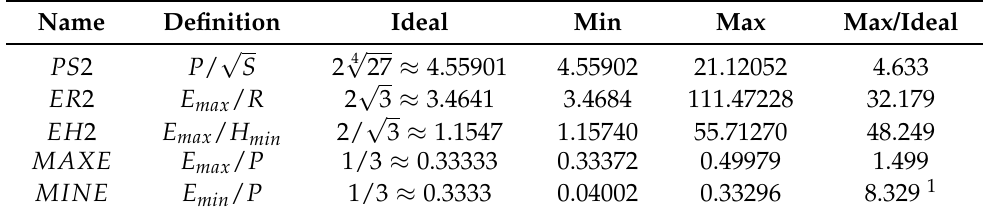
Figure 9. The membrane of the bouton ( purple ), the artificial cut surface ( blue ), fragments of the microtubules ( green ) and a fragment of the mitochondrion ( yellow ) with surfaces covered by triangles − two-dimensional mesh. Table 5. Surface mesh quality of the real 3D model.